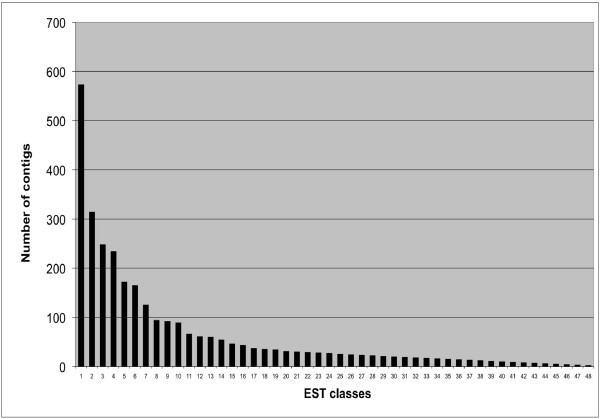
Frequency and distribution of pigeonpea ESTs among assembled contigs. Number of ESTs in EST classes (on X-axis) are as following: Class 1=2 , Class 2 = 3, Class 3 = 4, Class 4 = 5, Class 6 = 7, Class 7= 8, Class 8 = 9, Class 9 = 10, Class 10 = 11, Class 11 = 12, Class 12= 13, Class 13 = 14, Class 15 = 16, Class 16 = 17, Class 17 = 18, Class 18 = 19, Class 19 = 20, Class 20 = 21, Class 21 = 22, Class 22 = 23, Class 23 = 24, Class 24 = 25, Class 25 = 27, Class 26 = 28, Class 27 = 29, Class 28 = 30, Class 29 = 31, Class 30 = 34, Class 31 = 35, Class 32= 37, Class 33 = 43, Class 34 = 46, Class 35 = 54, Class 36 = 60, Class 37 = 61, Class 38 = 66, Class 39 = 89, Class 40 = 92, Class 41 = 94, Class 42 = 125, Class 43 = 165, Class 44 = 172, Class 45 = 234, Class 46= 248, Class 47 = 314 and Class 48 = 573.